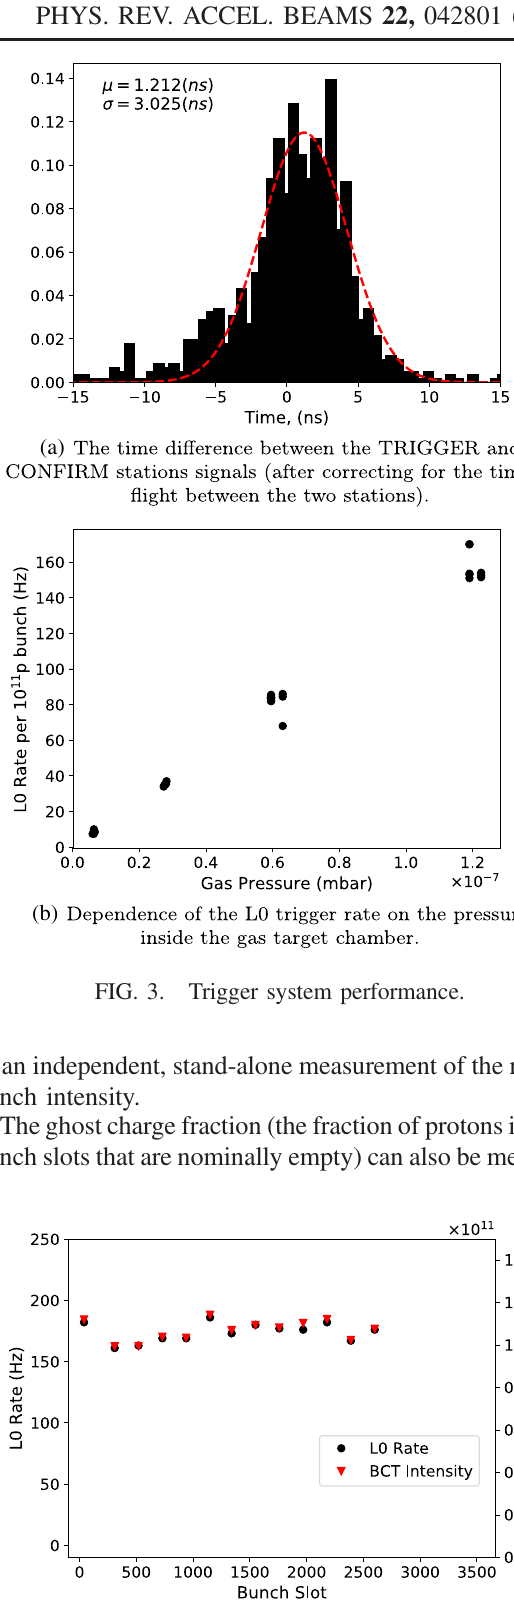
FIG. 4. The BGV L 0 trigger rate per bunch for an LHC fill with 13 bunches (circles) and an independent measurement of the bunch populations made with the LHC BCT system (rectangles, with values referring to the scale on the